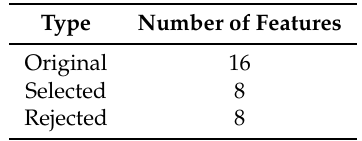
Table 7. RFE features for a UMass Electric Dataset.